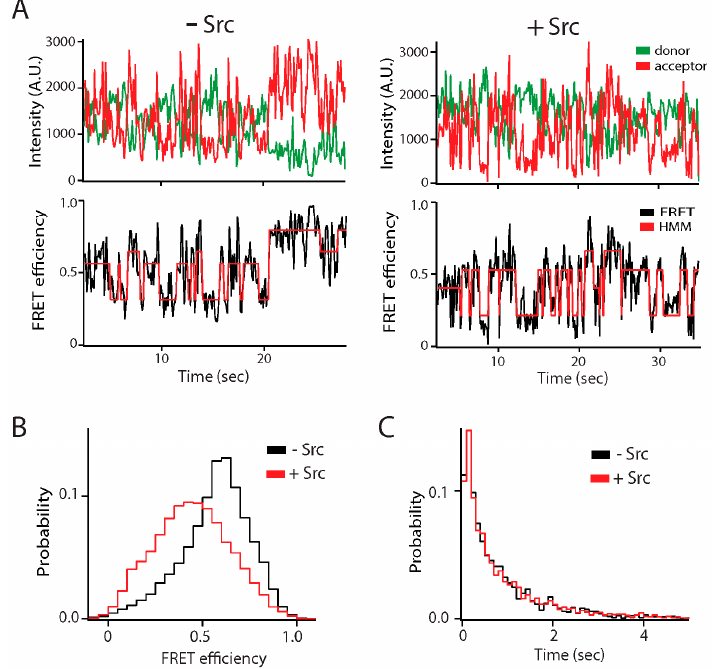
Figure 3. Effect of Src kinase phosphorylation on the conformational ensemble of the NMDA receptor. The C-terminal intrinsically disordered region (IDR) of the GluN2B subunit of the NMDA receptor (C-term-N2B) was randomly labeled with donor and acceptor fluorophores at residues 1323 and 1453 [31]. Src kinase phosphorylates C-term-N2B on tyrosine residues 1336 and 1472. ( A ) Representative single molecule fluorescence intensity (top panels) and fluorescence resonance energy transfer (FRET) efficiency fit by hidden Markov modeling (HMM) (bottom panels) for unphosphorylated (left) and phosphorylated (right) C-term-N2B. Phosphorylation did not induce structure in C-term-N2B as the dynamic transitions continued. ( B ) FRET efficiency histogram of C-term-N2B before (black line) and after (red line) Src phosphorylation. Phosphorylation led to shift towards lower FRET indicating a general expansion of the polypeptide, which was confirmed with hydrodynamic measurements. ( C ) Dwell time histograms for transitions in C-term-N2B, obtained from HMM, before (black line) and after (red line) Src phosphorylation. Although phosphorylation shifted the ensemble FRET efficiency, stochastic transitions were unaffected. A.U.: Arbitrary units.